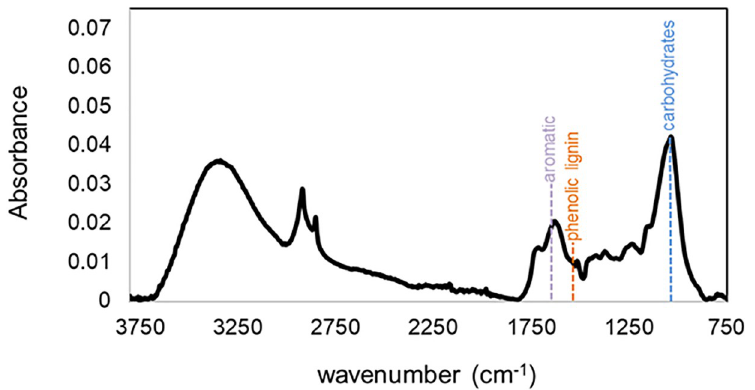
Fig 1. FTIR spectra of peat collected from an ambient enclosure at SPRUCE in September 2014 (depth = 25 cm). Following Hodgkins et al., [24], we focused on the peaks at 1040 cm -1 (O-alkyl of carbohydrates), 1510 cm -1 (phenolic lignin- like structures), and 1630 cm -1 (aromatic structures because these change in systematic ways in peat soils with depth at a single location and with latitude in surface soils. By normalizing the peaks to the area below the spectral curve, we can quantitatively observe changes in the chemistry of our